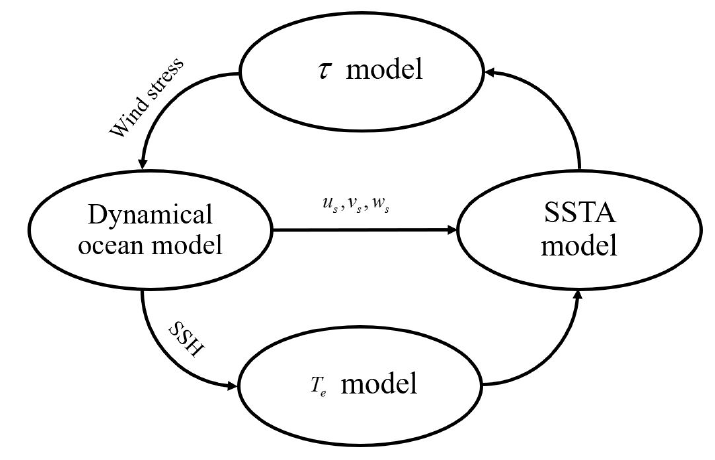
Figure 1. A schematic illustrating an Intermediate Coupled Model (ICM)